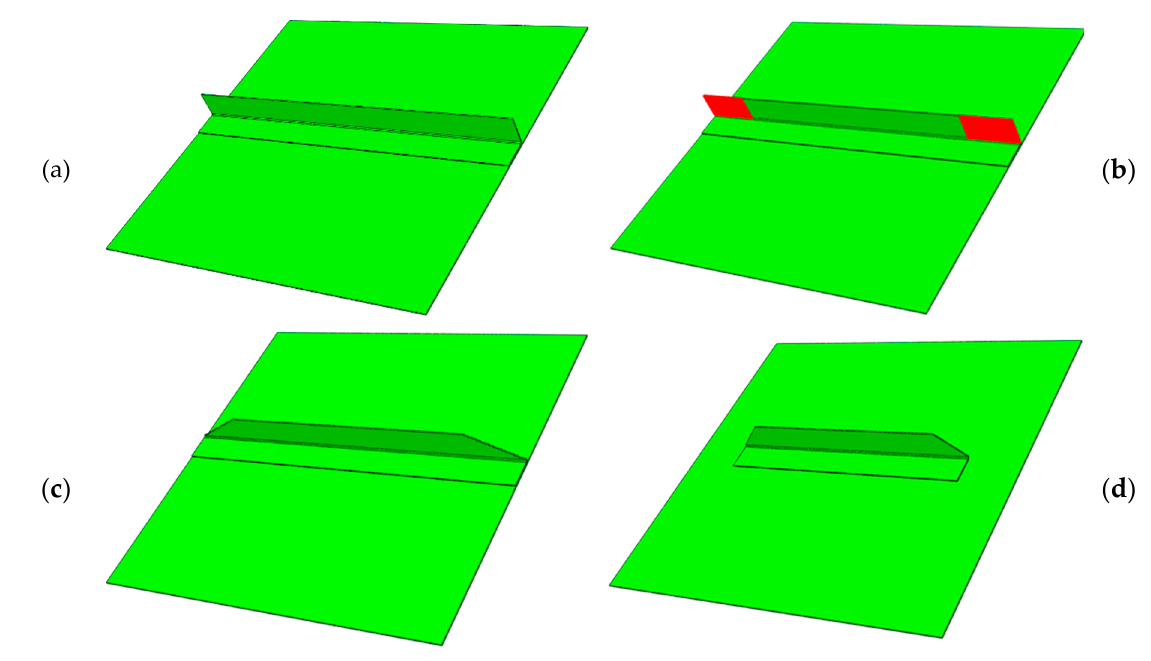
Figure 11. Test of some technological solutions regarding the stiffener geometry. ( a ) Reference case: full and uninterrupted stiffener; ( b ) blocked web: transverse motion blocked on the red areas, matching the tabs region; ( c ) tapered web: triangle cut on the tab region; ( d ) interrupted stiffener (and tapered web): limited to the useful zone, i.e., out of the tab region.